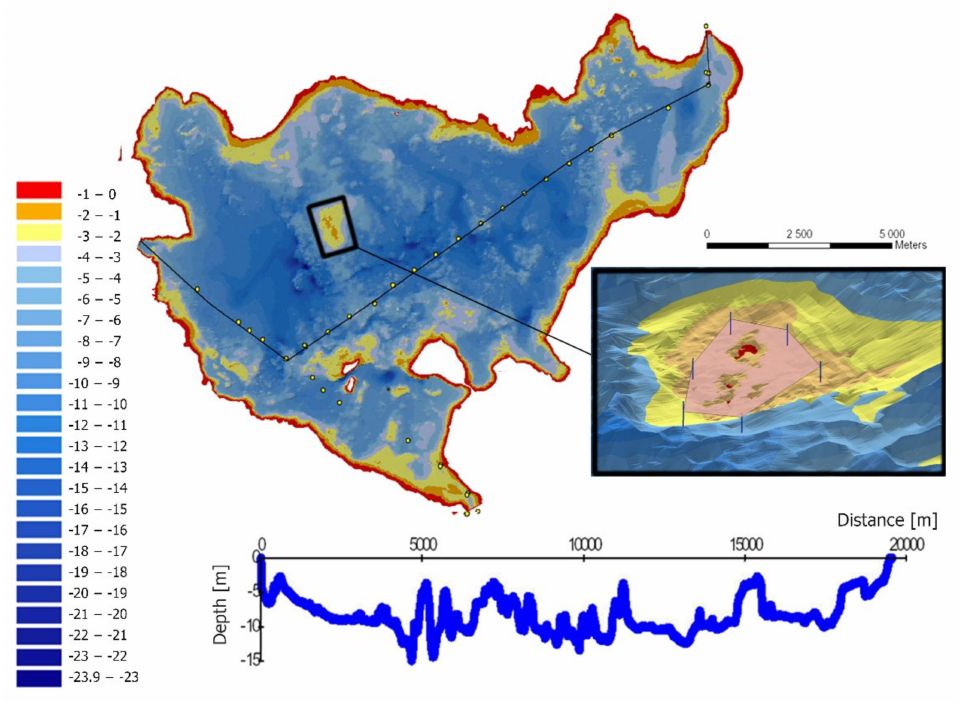
Figure 8. Marking the navigable route on the largest lake in Poland, ´Sniardwy Lake, with the depth profile along the route. Inset map presents a sample of cardinal buoy location (IALA system) used to mark hazardous locations obtained from GIS analyses.